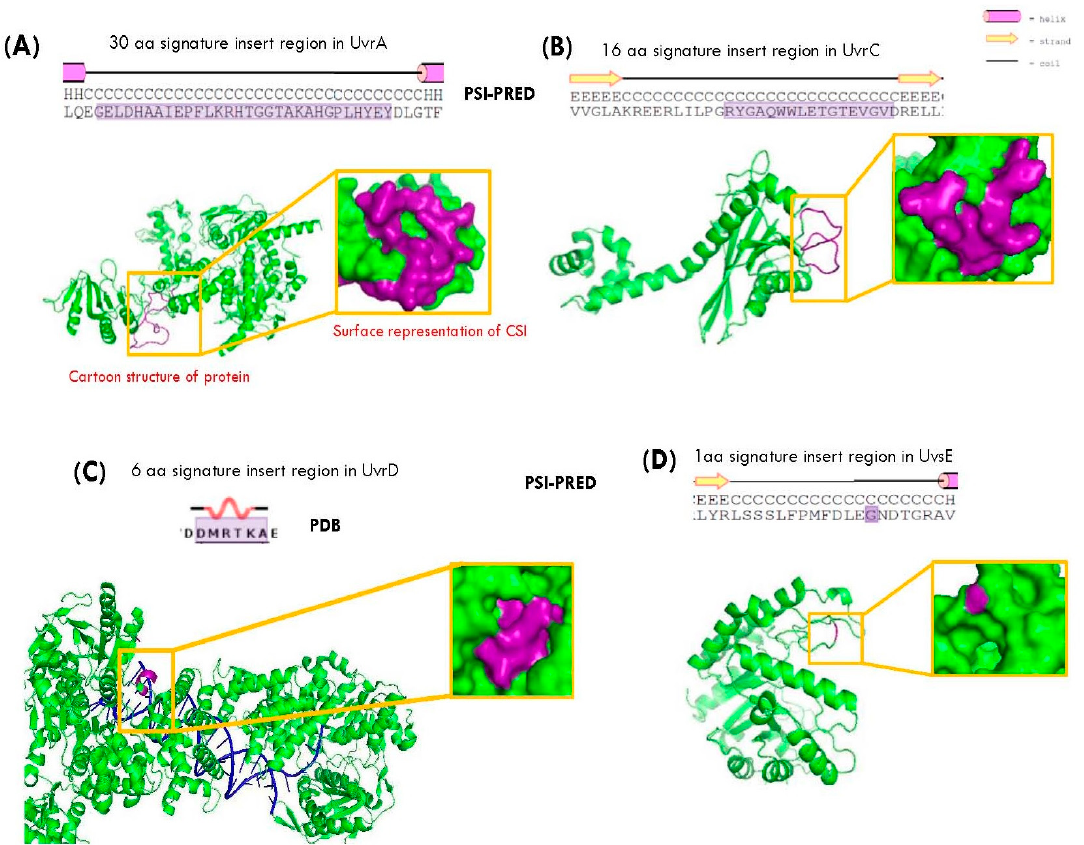
Figure 3. Secondary structure characteristics and structural locations of the identified CSIs in some DNA repair proteins. ( A ) Carton and surface representation of the location of the 30 amino acid CSI in the modeled structure of the UvrA1 protein from D. radiodurans ; ( B ) Location of the 16 amino acid CSI in the modeled structure of UvrC protein; ( C ) Cartoon and surface representation of a 6 amino acid CSI in crystalized UvrD protein (PDB id: 4C2T); ( D ) Structural analysis of the 1 amino acid CSI in UvsE protein in the modeled structure of D. radiodurans .